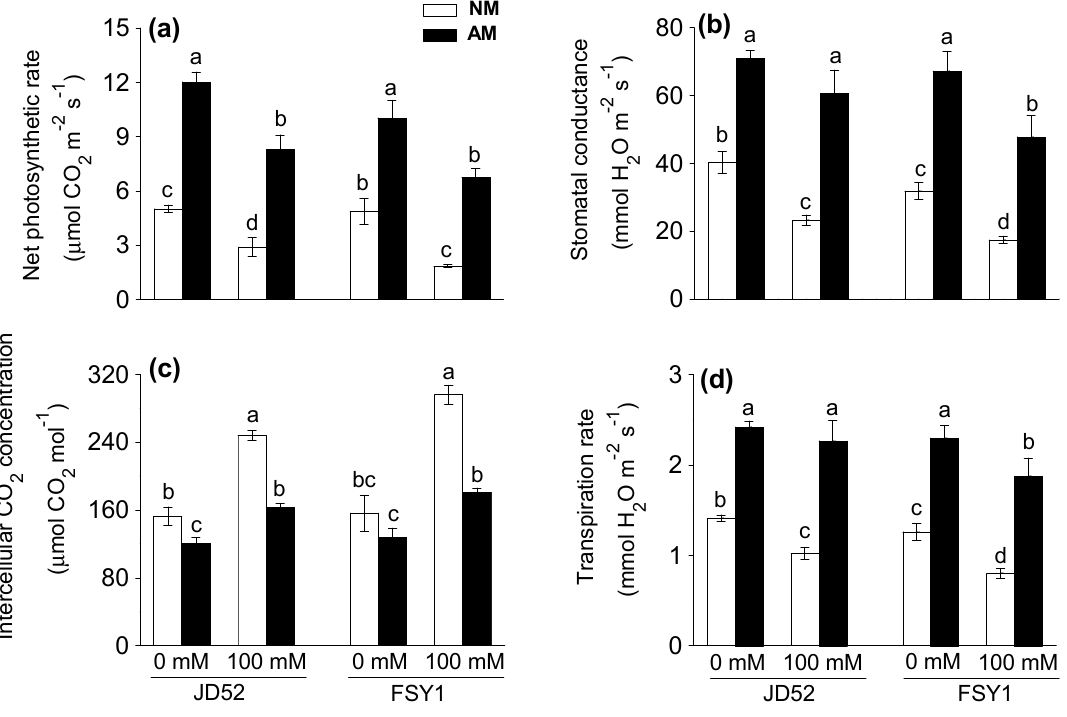
Figure 2. Net photosynthetic rate ( a ), stomatal conductance ( b ), intercellular CO 2 concentration ( c ), transpiration rate ( d ) in two maize genotypes (JD52 and FSY1) inoculated with Funneliformis mosseae (AM) or without inoculation (NM) in 0 and 100 mM NaCl treatments assessed at 59 DAS. For each trait, bars with different letters indicate significant differences ( p ≤ 0.05).